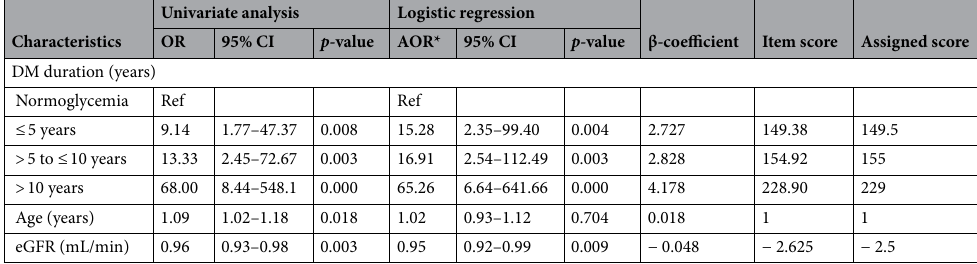
Table 4. Multivariate logistic regression analysis with coefficient values of each factor and their assigned score for predicting osteogenic differentiation impairment in type 2